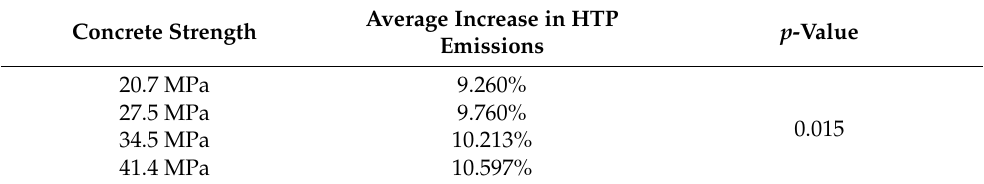
Table 15. HTP p -value for concrete strength and average increase in emissions with increasing CS.